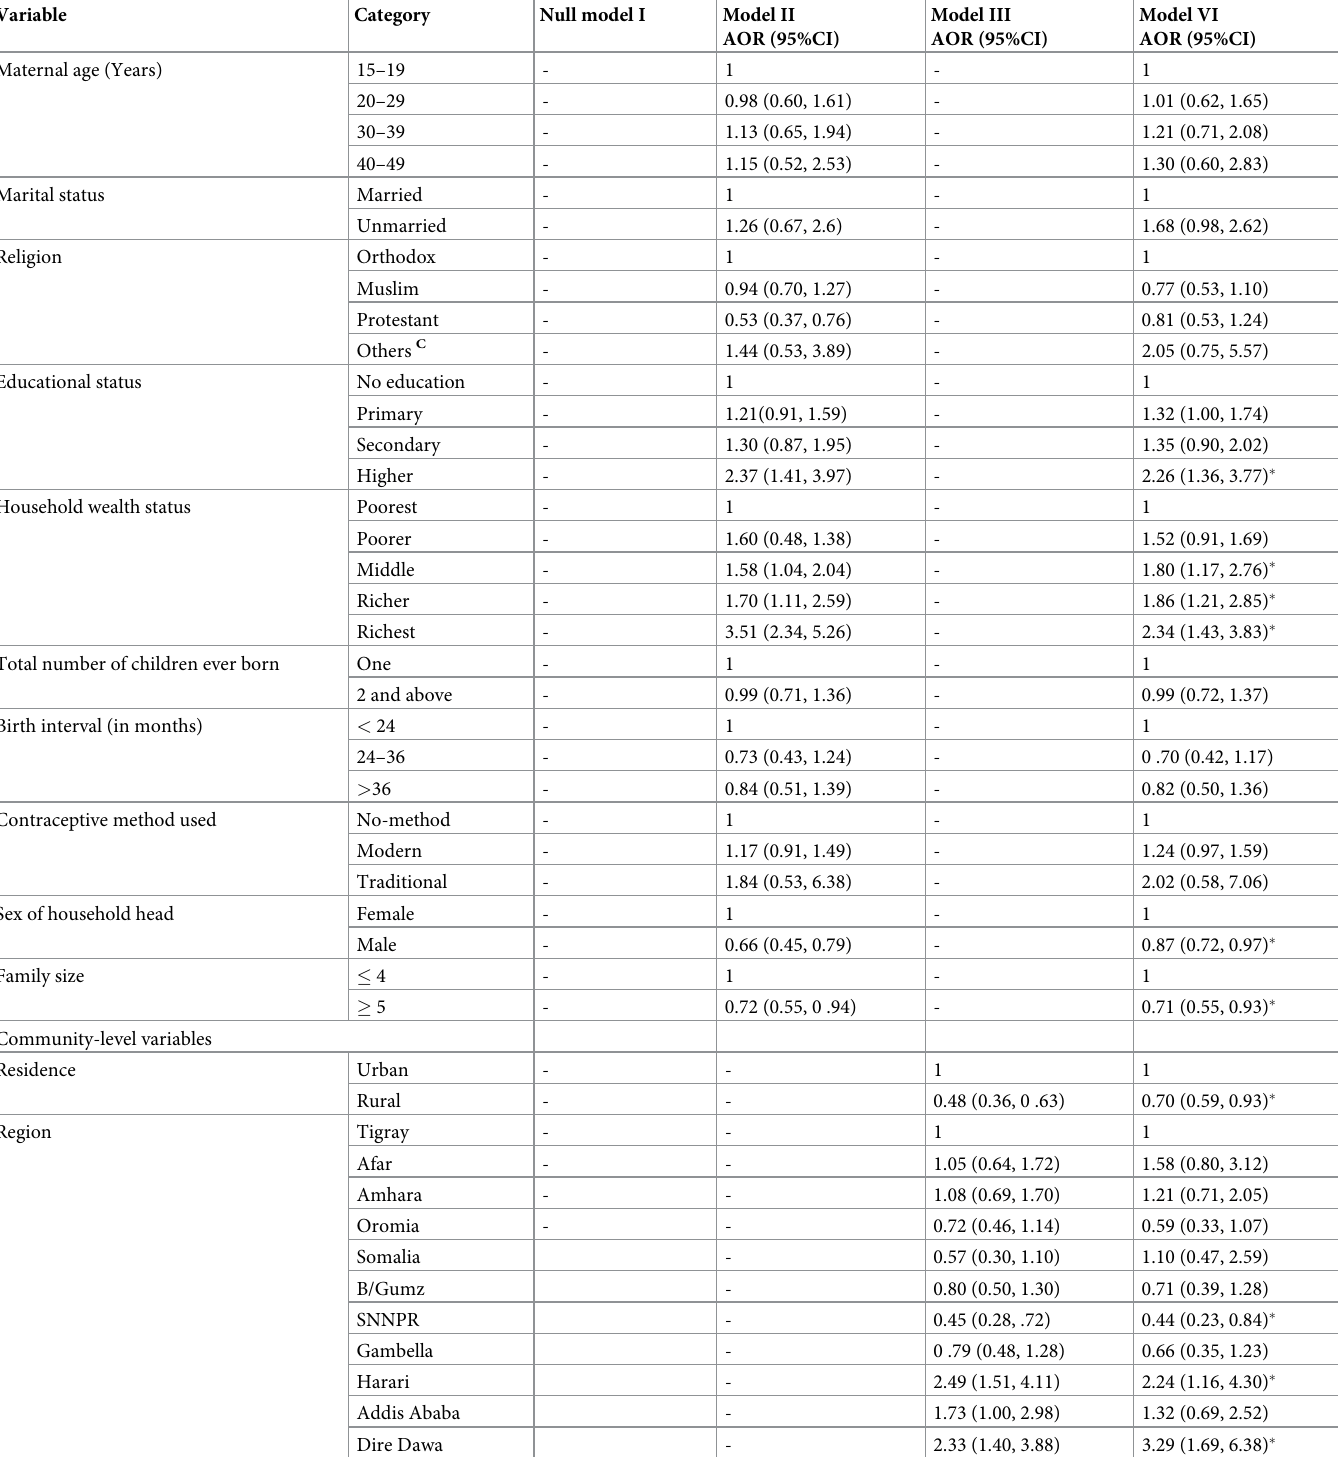
Table 5. Multilevel logistic regression analysis to assess determinants of early initiation of first ANC visits among reproductive-age women in Ethiopia, 2019.